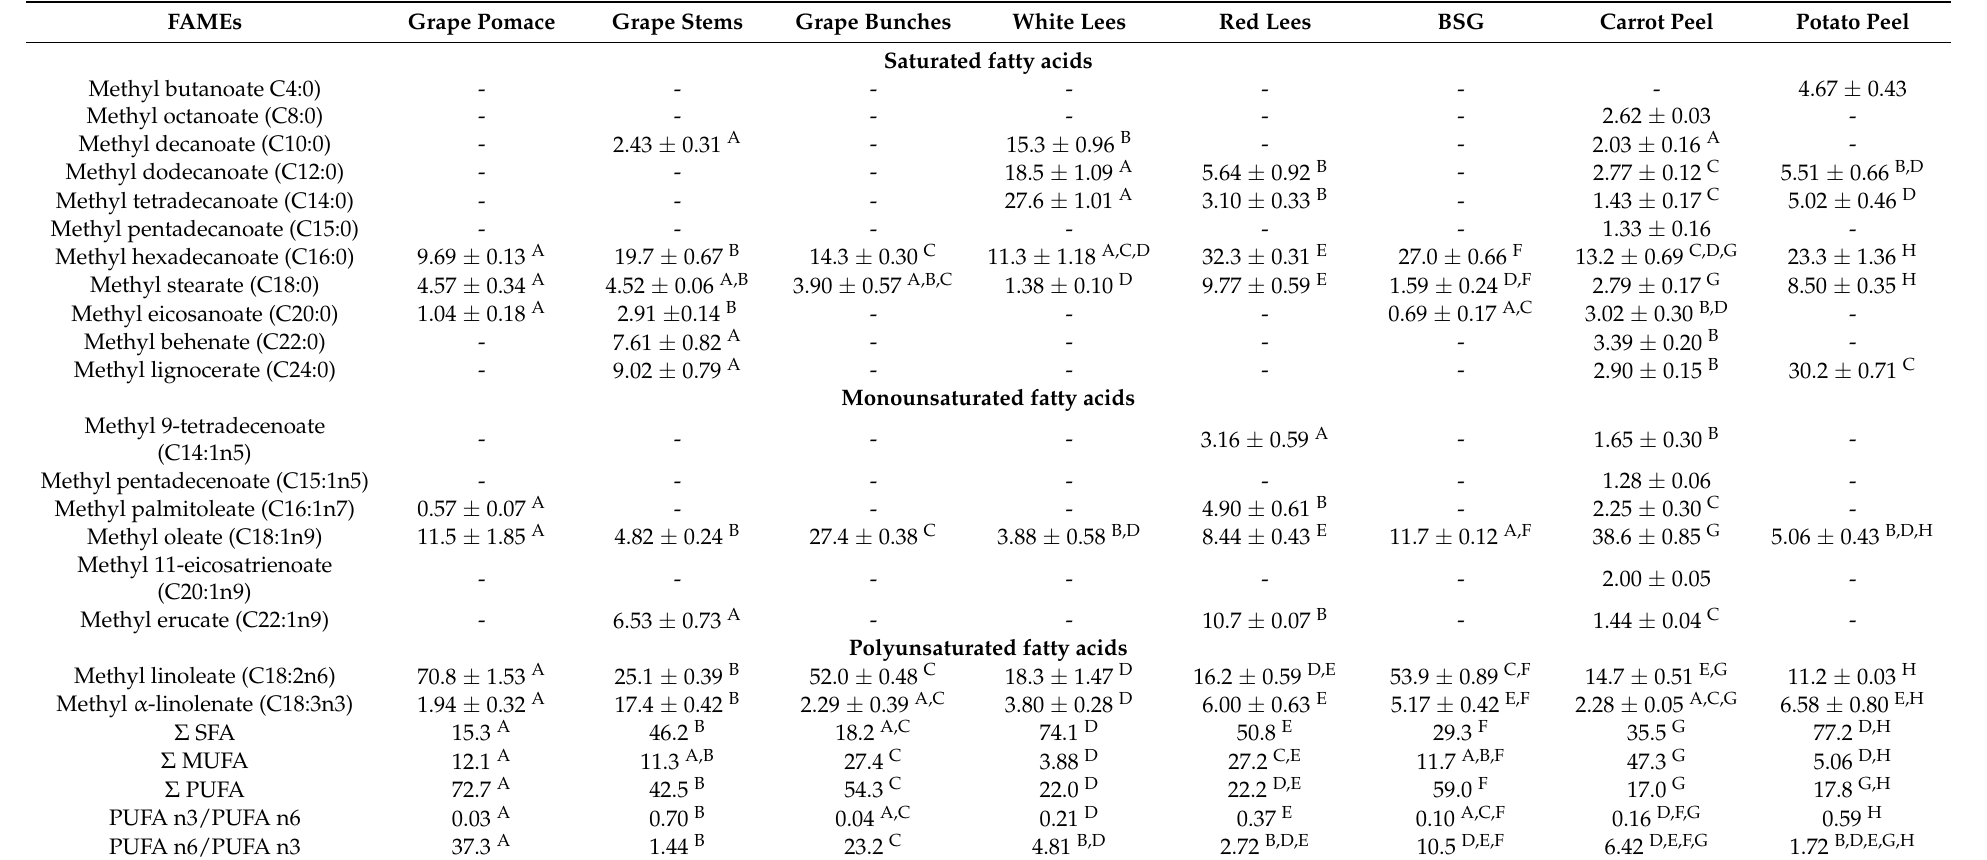
Table 2. Fatty acids methyl esters (FAMEs) profile (g/100 g of dried sample ± standard deviation) of agri-food by-products.